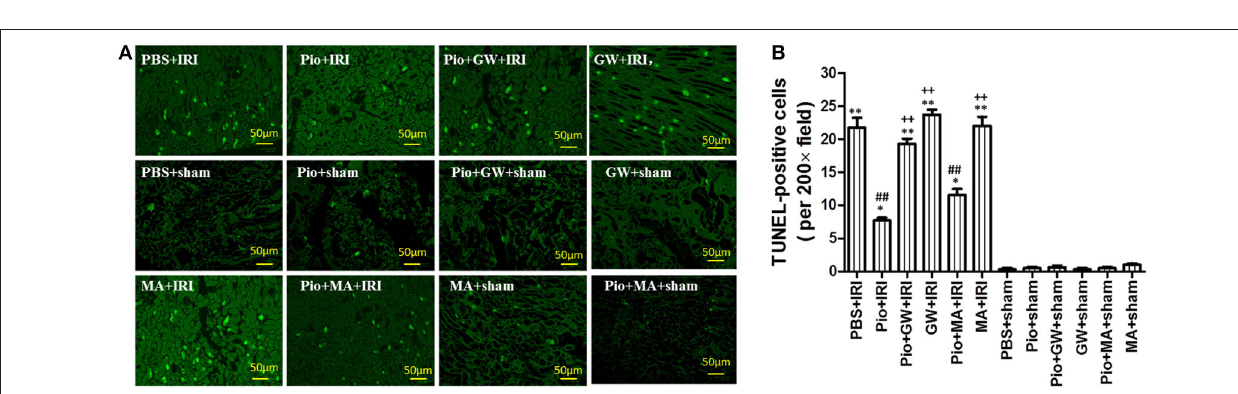
Frontiers in Pharmacology |